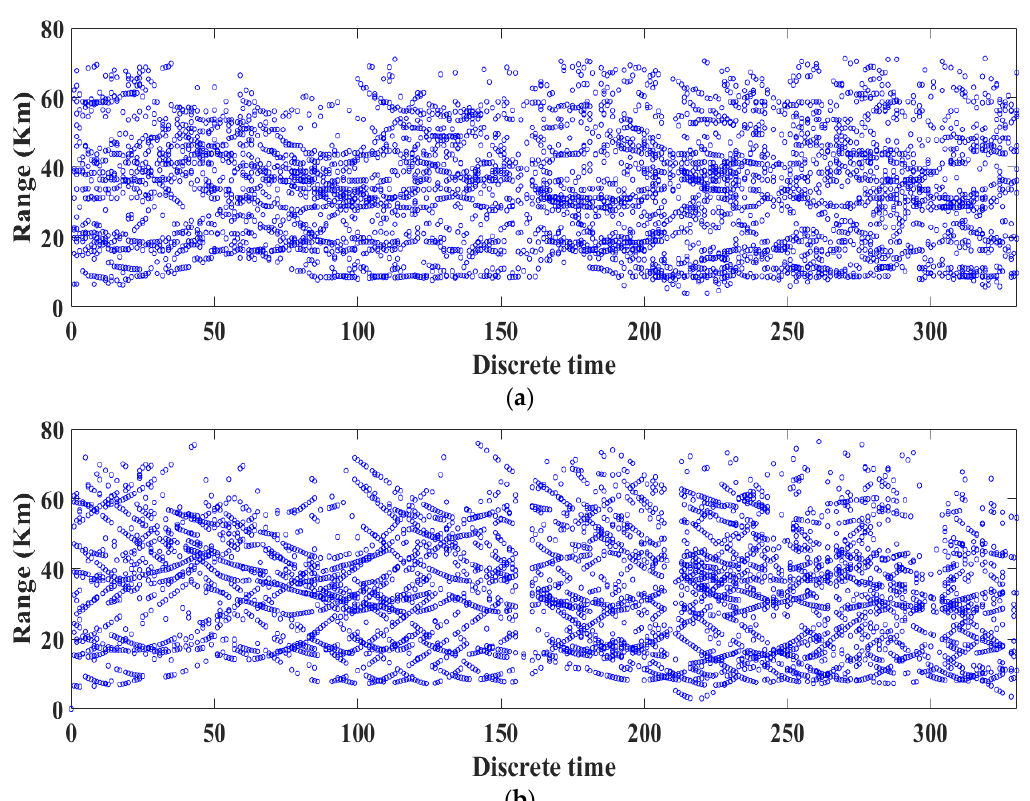
Figure 14. Range-time trajectories of matched targets on 25 September 2015. ( a ) CA-CFAR; ( b ) TF-CFAR.